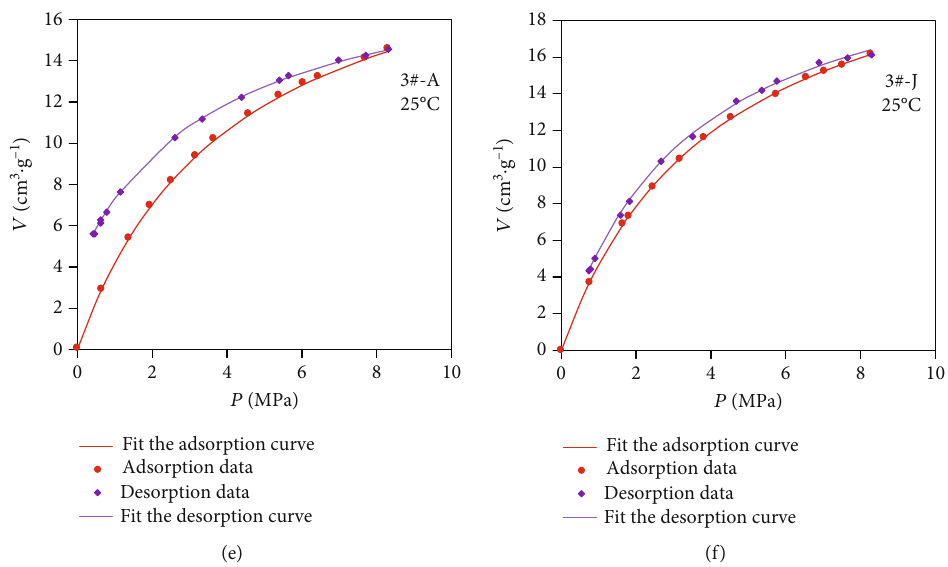
Figure 8: Isothermal adsorption-desorption curves of vitrain and durain.